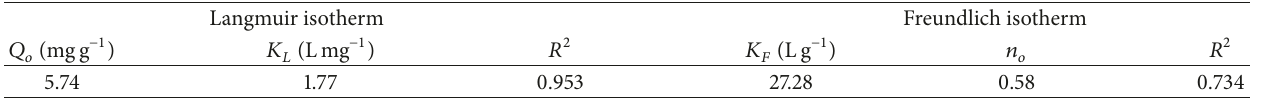
(pH = 3 ), 2g of CA-MC-Cy prepared with 1molL −1 of extractant reagent, room temperature.